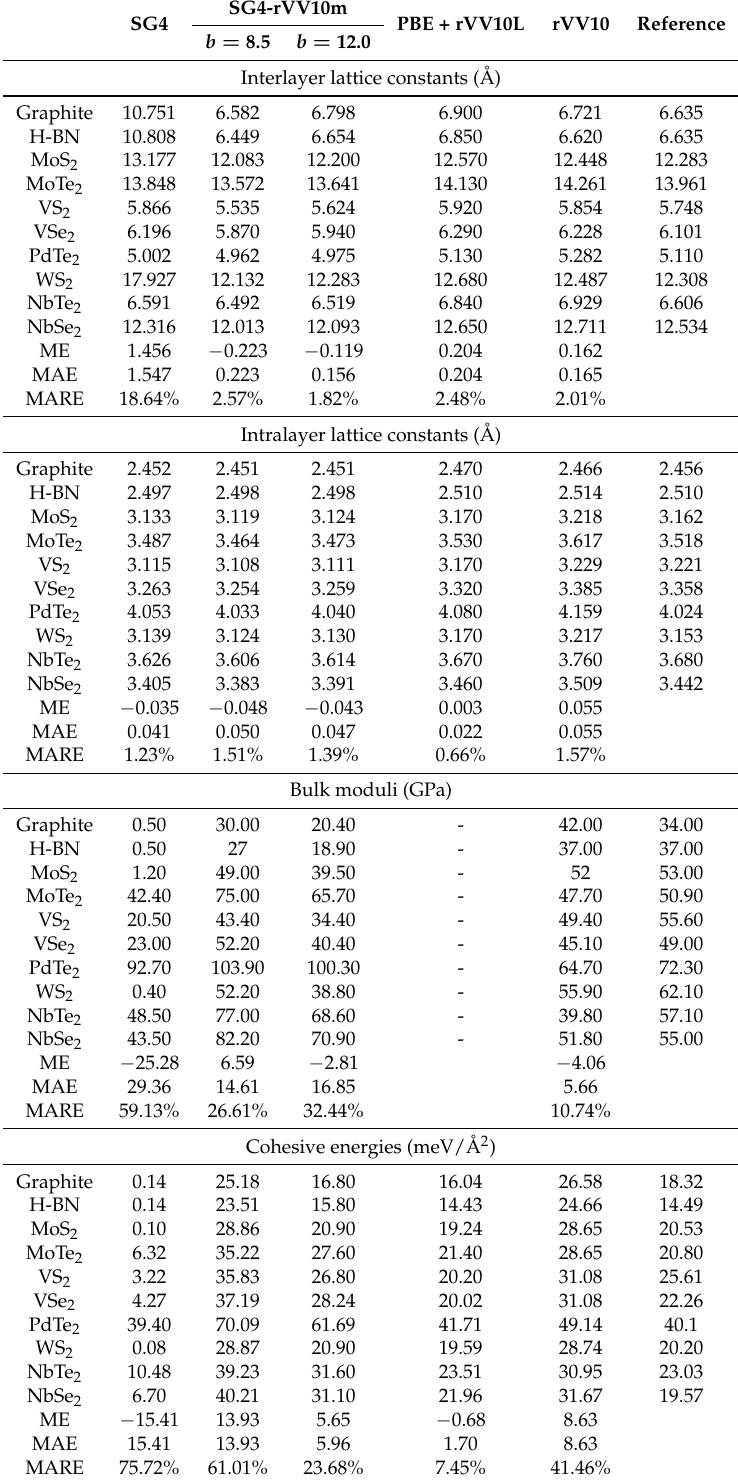
Table 3. Lattice constants, bulk moduli, and cohesive energies of several layered materials as obtained with different functionals. The reference lattice constants are experimental values [21] (corrected for zero-point vibrational effects), reference bulk moduli are VV10 results [20], and reference cohesive energies are Random Phase Approximation (RPA) values [20,21]. For each property, we also report the mean error (ME), the mean absolute error (MAE), and the mean absolute relative error (MARE).